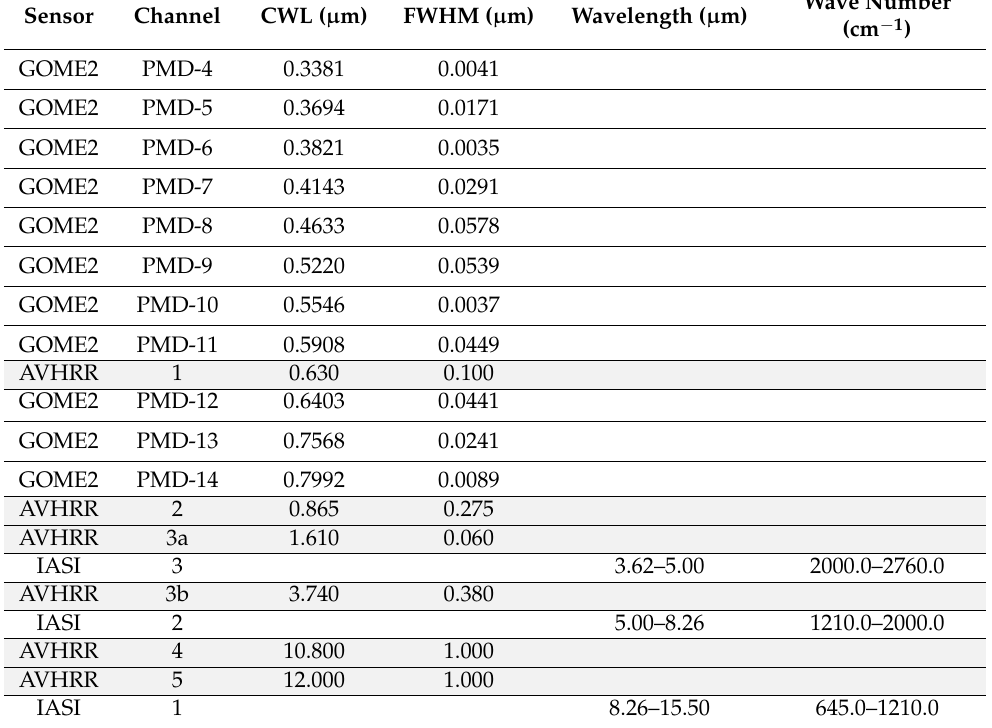
Table 1. Band definition for the EPS instruments contributing to the spectral synergy used in PMAp and sorted by increasing wavelength. PMD bands from GOME2 with their central wavelength (CWL in µ m) and full width half maximum (FWHM in µ m). Values are an average of PMD-S and PMD-P bands [29]. Only PMD-4 to PMD-14 are used in PMAp. Spectral Characteristics of AVHRR with their CWL and FWHM. IASI main spectra feature with min-max wavelengths and wave numbers (in cm − 1 ).